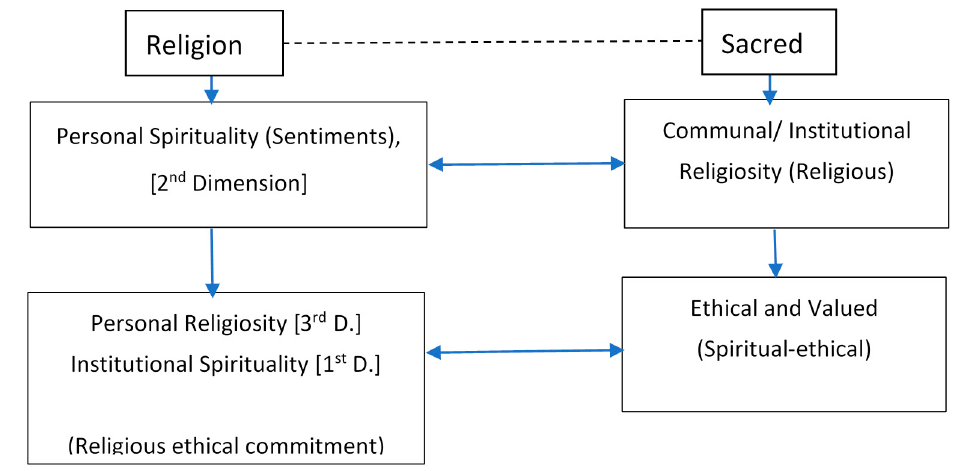
Figure 3. Conceptual inter-relationship of students’ notions of sacred and religion.